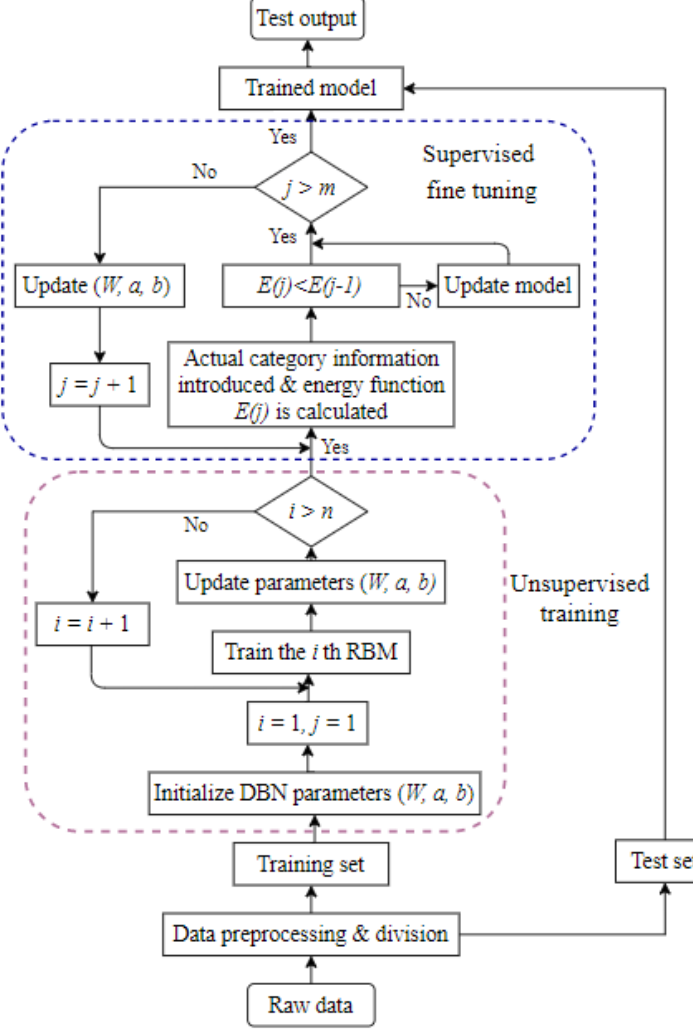
Figure 11. Fault diagnosis framework of DBN.